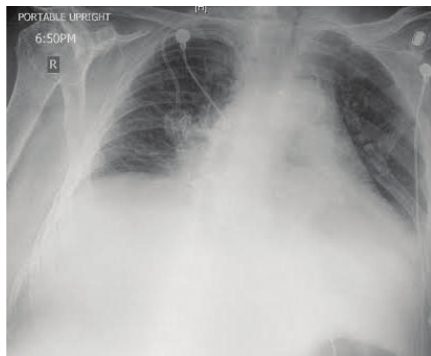
Figure 1: Chest X-ray suggestive of an enlarged cardiac silhouette.